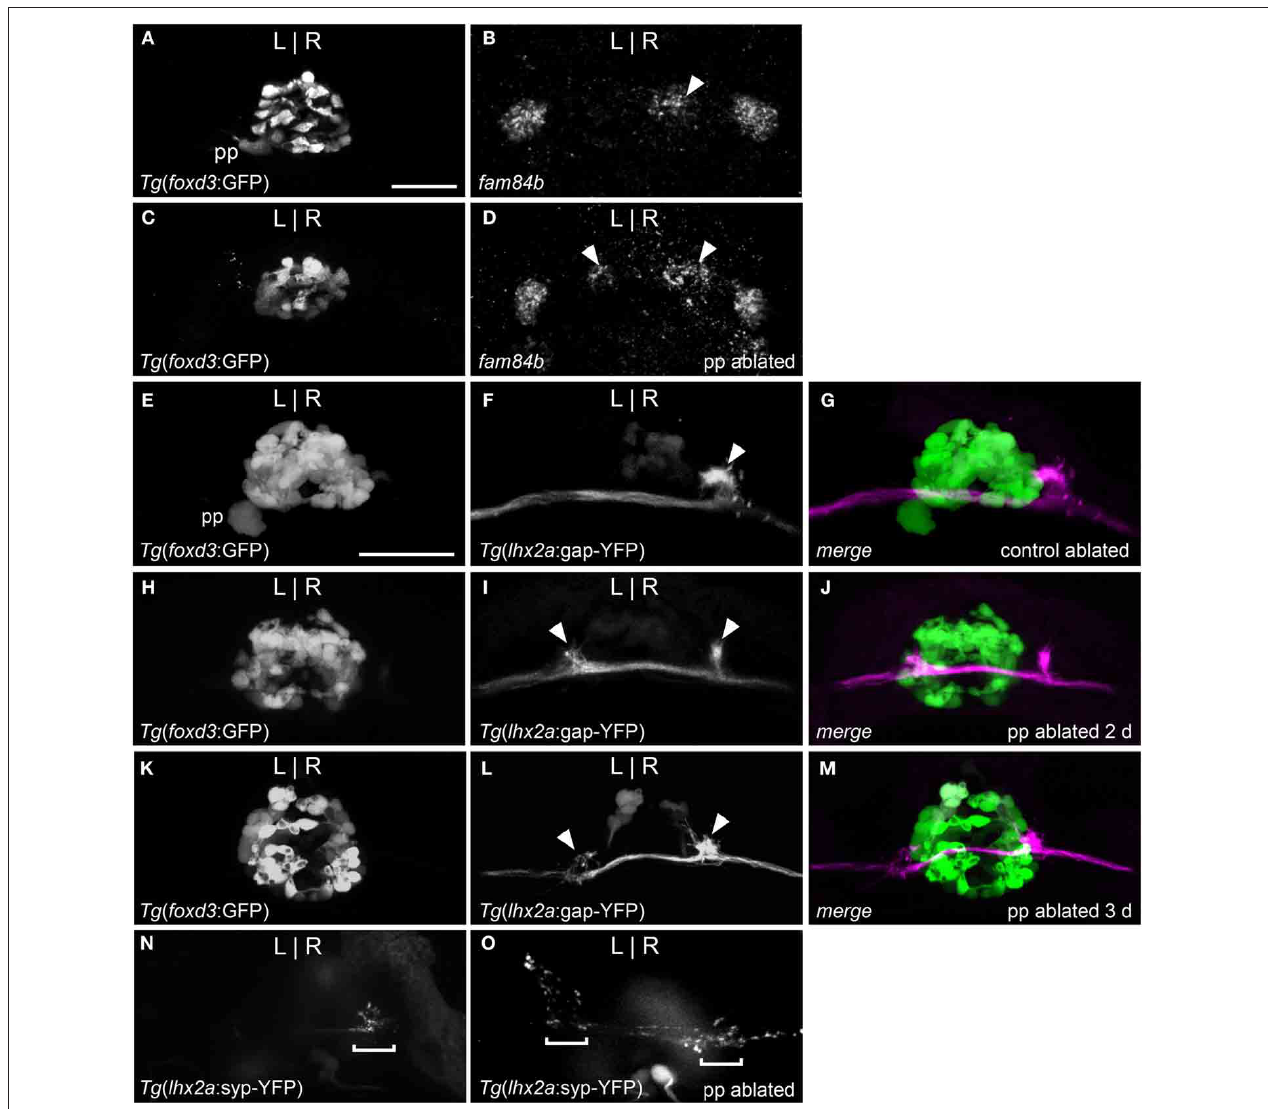
control-ablated larvae, but (H) in the absence of the parapineal, they terminate (I,J) at both habenulae (white arrowheads in I ). (K–M) Parapineal ablation at 3 dpf also results in bilateral lhx2a:YFP projections (white arrowheads in L ). (N) Region of synaptic vesicle density (demarcated by bracket) in the right dorsal habenula of Tg ( -10lhx2a:SYP-GFP ) zf186 larva is found (O) bilaterally following parapineal ablation. All images, except for (B,D) are of live larvae at 4 dpf, 5 dpf (K–M) and 6 dpf (N,O) . Scale bars = 40 μ